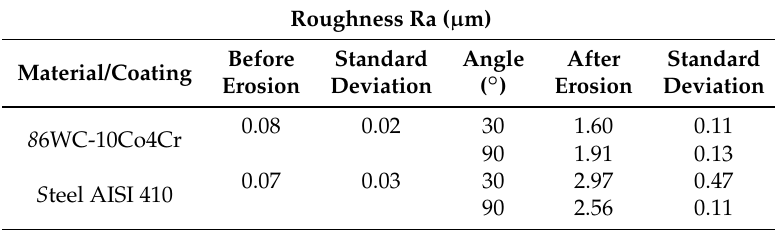
Table 5. Average roughness of coating and substrate before and after jet slurry